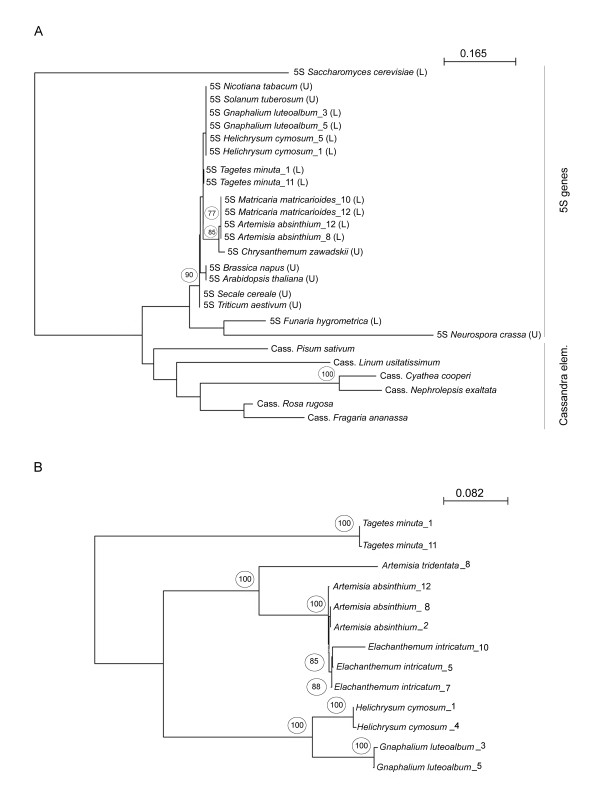
Phylogenetic analysis of the 5S genic (A) and intergenic spacer 1 (IGS1) sequences (B). The arrangement of rRNA genes is depicted by U (unlinked) and L (linked). The phylogenetic positions are based on the nearest neighbor analysis of multiple alignments. Accession numbers of taxa are given in Additional file 4. The "5S" and "Cass." symbols before the taxon name indicate either 5S genic or Cassandra sequences. Numbers above branches indicate bootstrap percentages >70. The Saccharomyces cereviseae 5S gene was used as outgroup in (A). The IGS1 cladogram is an unrooted tree. Scale bars indicate the number of base substitutions per site.